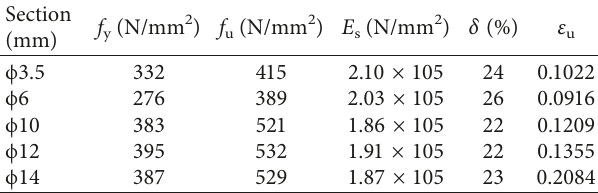
Table 1: Summary of the properties of reinforcing bars. Section